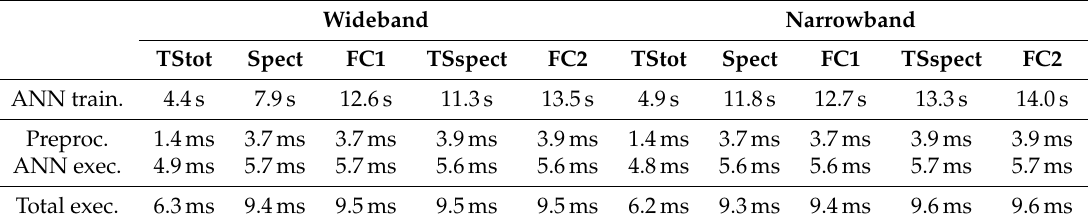
Table 1. Execution time benchmarks for wideband as well as narrowband excitation. Wideband Narrowband TStot Spect FC1 TSspect FC2 TStot Spect FC1 TSspect FC2 ANN